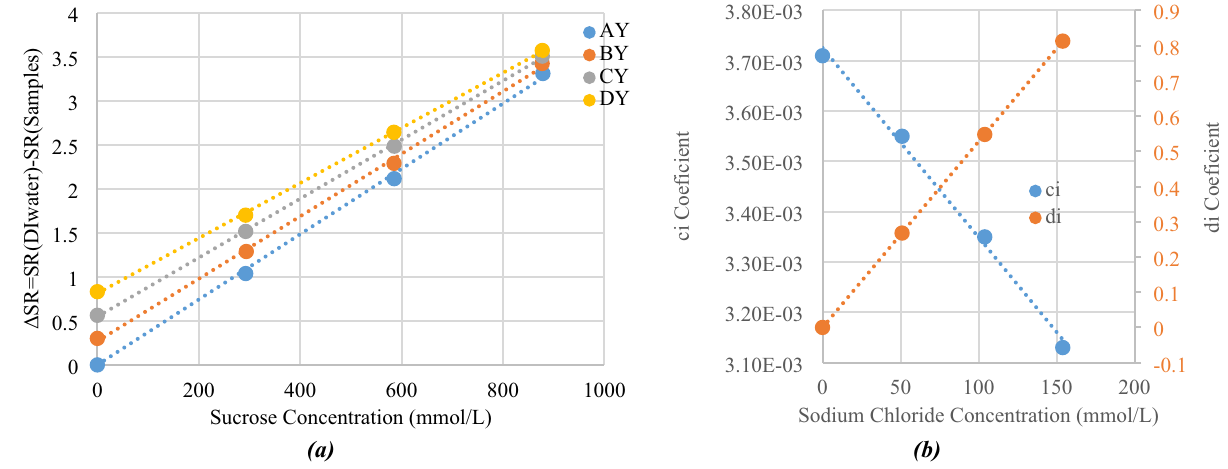
Figure 16. ( a ) Simulated values of SR as a function of sucrose concentration, and ( b ) slope c i and origin d i of the first-order approximations as a function of sodium chloride